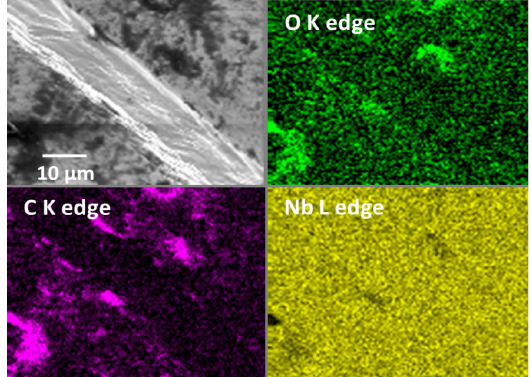
FIG. 11. EDX mapping of a region next to a grain boundary on the bent